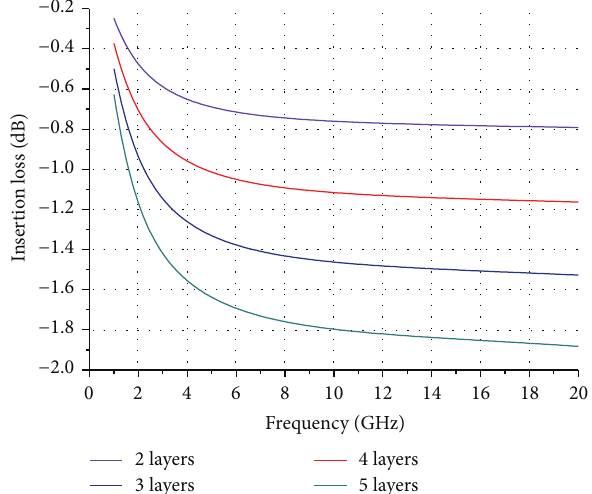
Figure 7: Insertion loss of multilayer TSV.